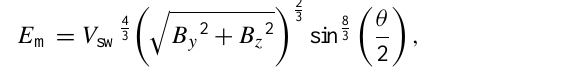
Fig. 6. Same as Fig. 5, but for the poleward auroral boundary.